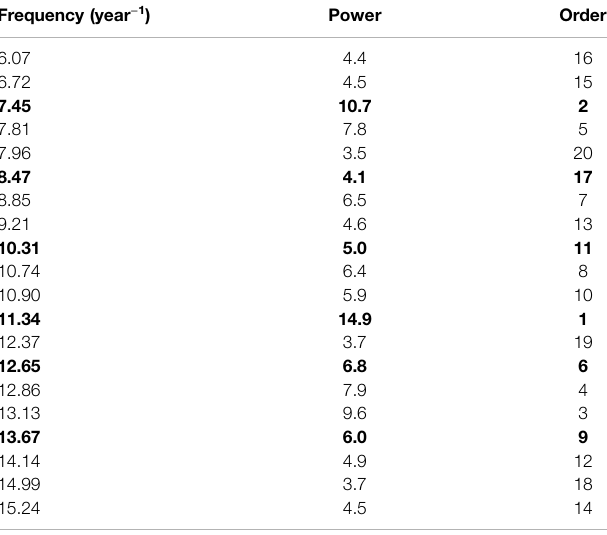
TABLE 5| Top20peaksinthepowerspectrumformedfrom GSInoon datainthe frequency band 6 – 16 year − 1 . Table adobted from [28].